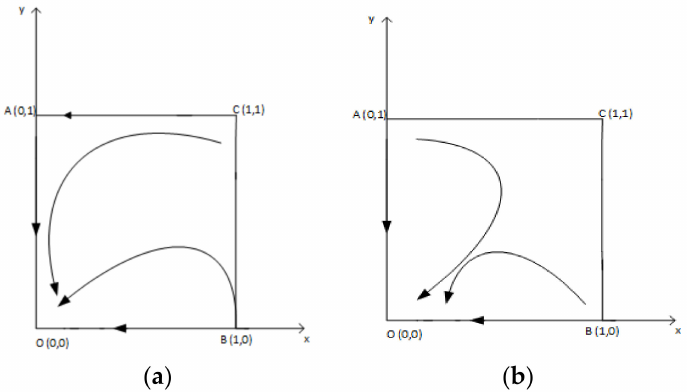
Figure 1. Evolutionary game phase diagrams for inactive online lending platforms. ( a ) Scenario I; ( b ) Scenario